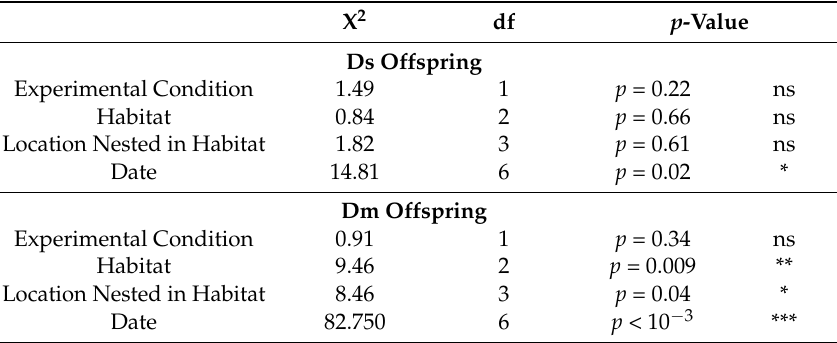
Table 2. Influence of experimental (Experimental Condition) and environmental (Habitat, Location, and Date) factors on the number of D. suzukii (Ds) and D. melanogaster (Dm) emerged from the Frozen Fruits traps. Levels of statistical significance: ns: not significant, * : 0.01 < p -Value ≤